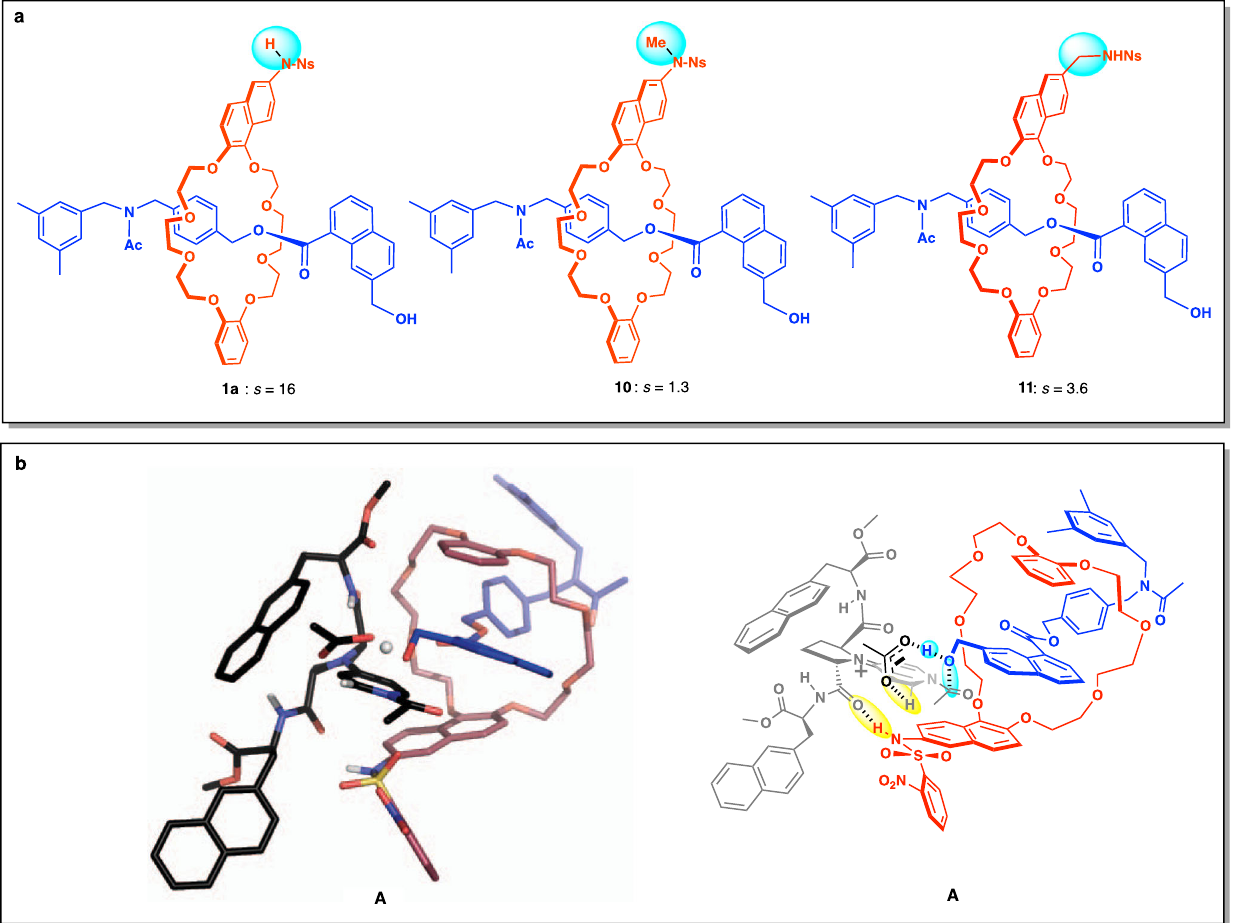
Fig. 4 Mechanistic implication for remote asymmetric acylation. a Relationship between substrate structure and the selectivity factor ( s ) of the kinetic resolution. The absolute con fi guration of recovered rotaxanes was not determined. b left: A calculated transition state model A for remote asymmetric acylation of rotaxane alcohol 1a with a catalyst model of 2 (the corresponding methyl ester of 2 ). Right: a schematic drawing of model A in which catalyst, ring component, axis component, and carboxylate anion are shown in grey, red, blue, and black, respectively. Key hydrogen bonds are indicated by yellow circles. Structure A was generated by an ONIOM method (see S12) with constraint of hydrogen bonds indicated by yellow circles. Note that transition state model A is generated based on the assumption above, and it does not mean the most stable transition state